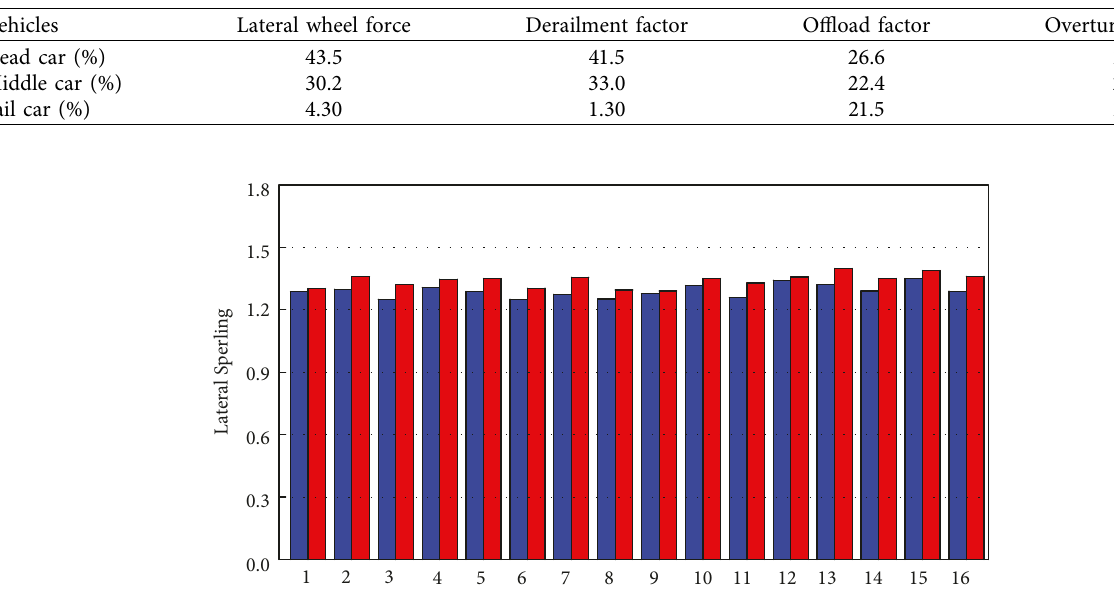
Table 4: Windbreak effect of wind